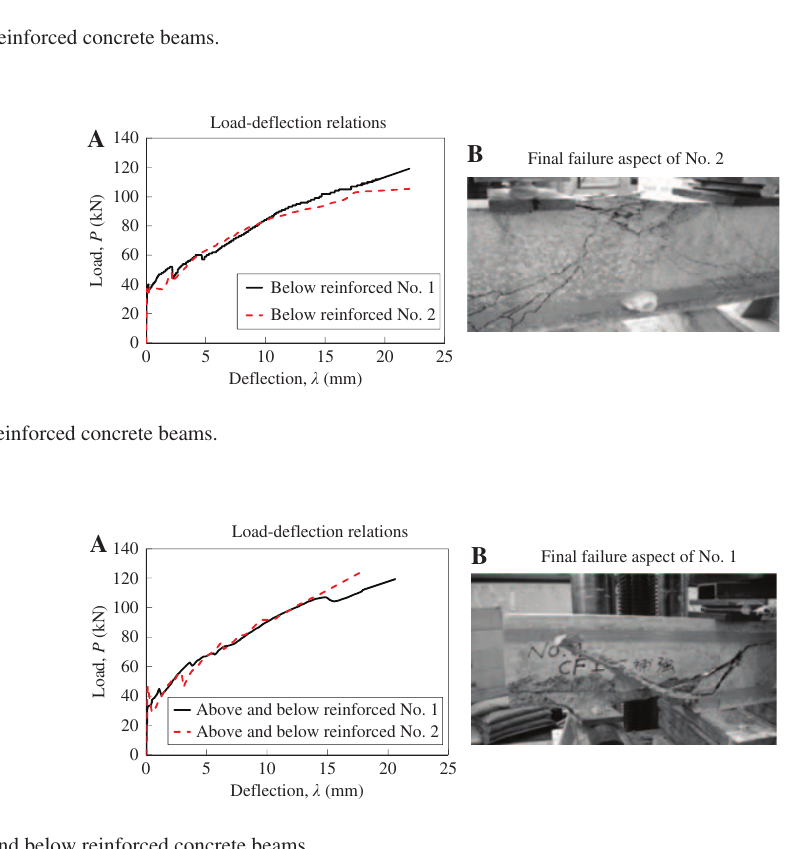
Figure 6 Above and below reinforced concrete